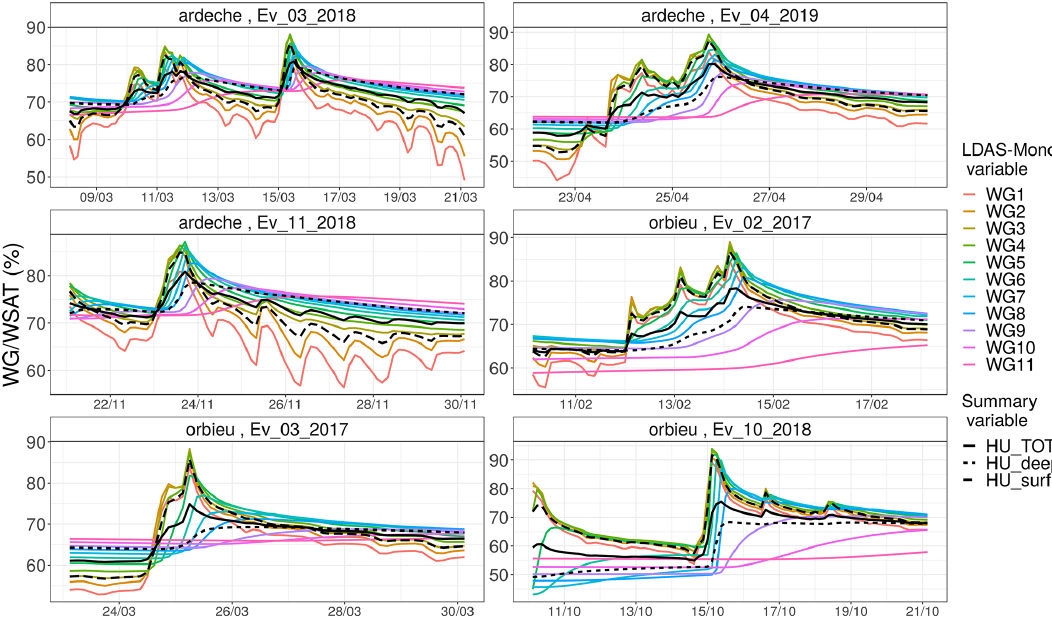
Figure B1. Soil saturation degree (%) for the 11 soil layers described in LDAS-Monde and summary variables HU surf (average of layers 1 to 5), HU deep (average of layers 6 to 11), and HU tot (average of layers 1 to 11), on average per catchment, for the six studied